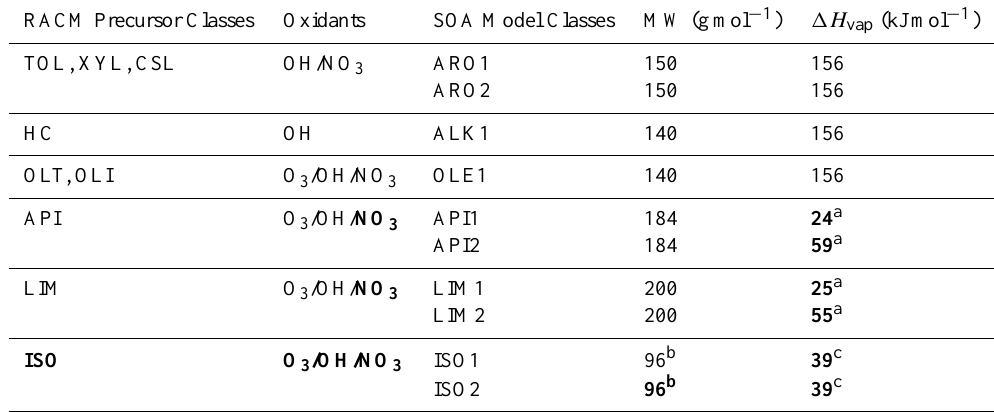
Table 1. SOA two-product species in SORGAM module.